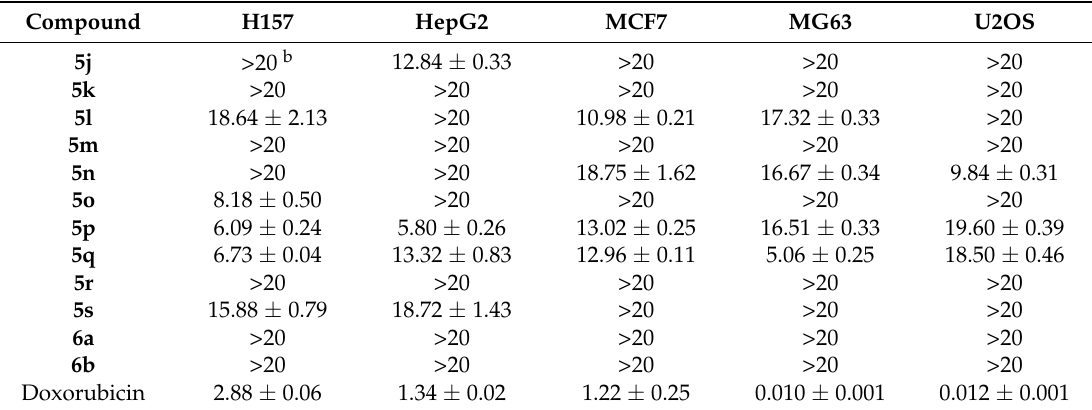
Table 2. Antiproliferative activity of selected compounds presented as IC 50 a ( µ